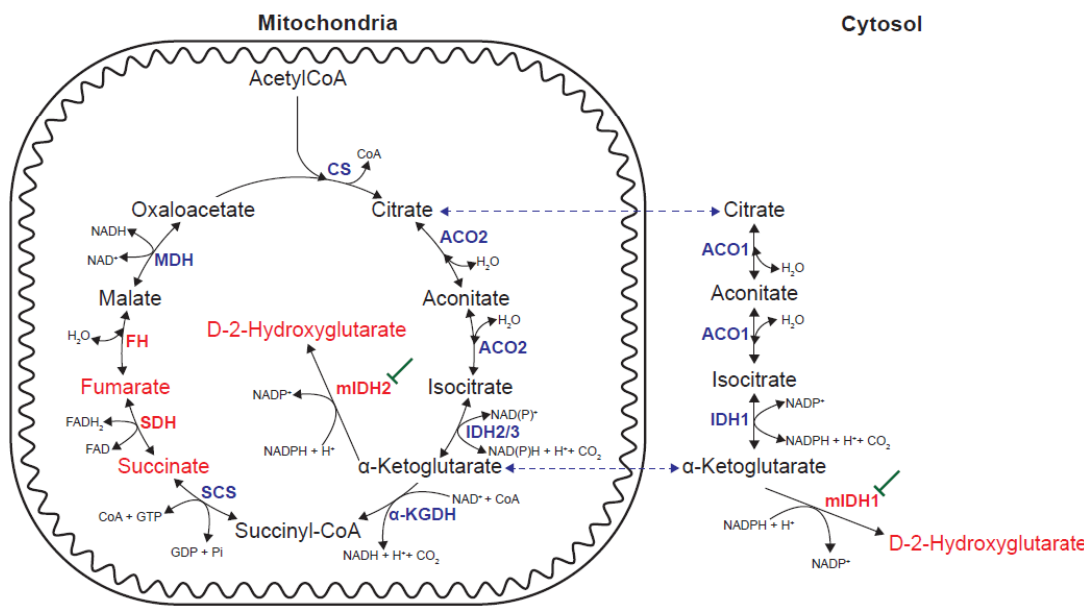
Figure 2. Alterations in enzymatic activities leading to the accumulation of oncometabolites. Gain-of-function mutations in IDH1/2 (mIDH1/2) lead to the production of D-2-hydroxyglutarate. mIDH1/2 can be pharmacologically inhibited. Loss-of-function mutations in SDH and FH lead to the accumulation of succinate and fumarate, respectively. CS: citrate synthase; ACO: aconitase; IDH: isocitrate dehydrogenase; α-KGDH: α-ketoglutarate dehydrogenase; SCS: succinyl-CoA synthetase; SDH: succinate dehydrogenase; FH: fumarate hydratase; MDH: malate dehydrogenase.